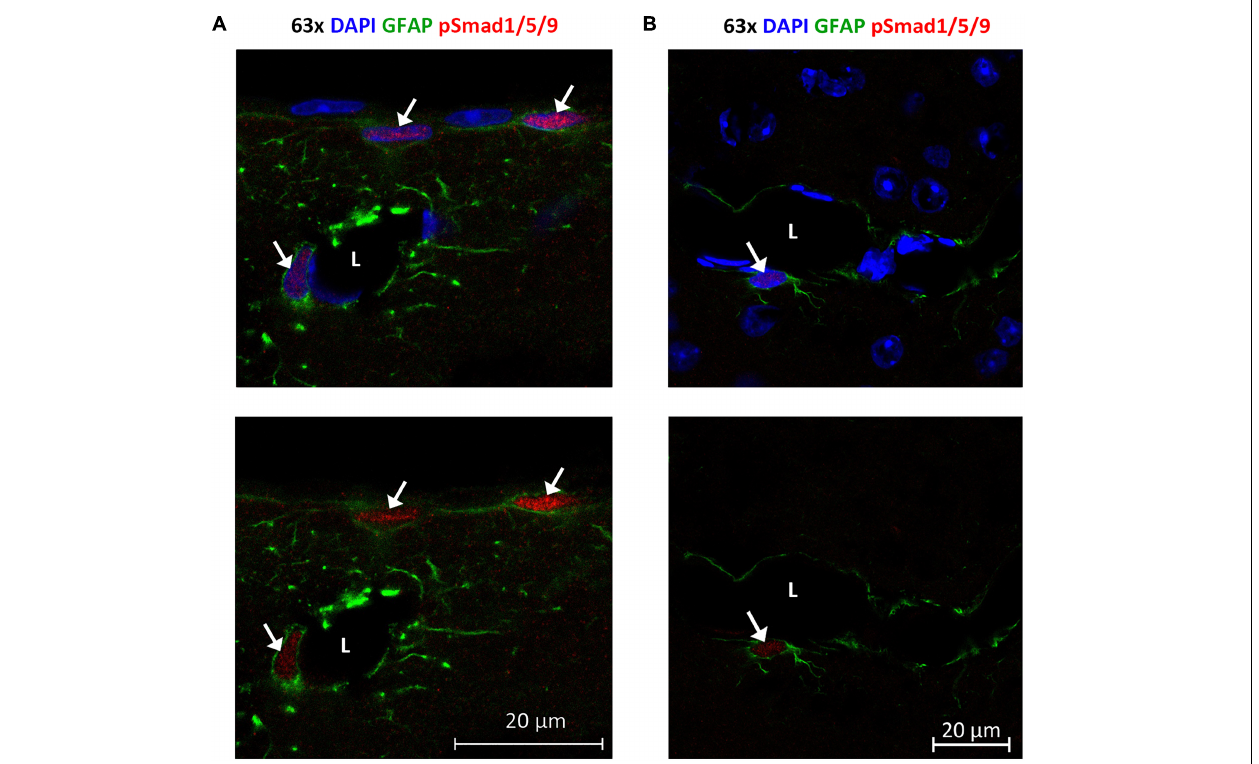
FIGURE 9 | Phosphorylated Smad1/5/9 is mainly localized in subpial and perivascular astrocytes. (A,B) Confocal images, Upper panel with DAPI nuclear staining confirm immunofluorescent phospho-Smad1/5/9 staining in astrocytes. (A) Astrocytes on the cortical surface and in association with blood vessels are positive (arrows) for nuclear phospho-Smad1/5/9 (red), while endothelial cells and pial cells are not. (B) Phospho-Smad1/5/9 (red) staining is present in the nucleus of a GFAP-positive astrocyte associated with a vessels (arrow), but nuclei belonging to endothelial cell lining the vessel, or nuclei in other GFAP-negative cells (some of them with a clear nucleolus) exhibit only very faint or no staining at all. L, vessel lumen. Scale bars = 20 µ